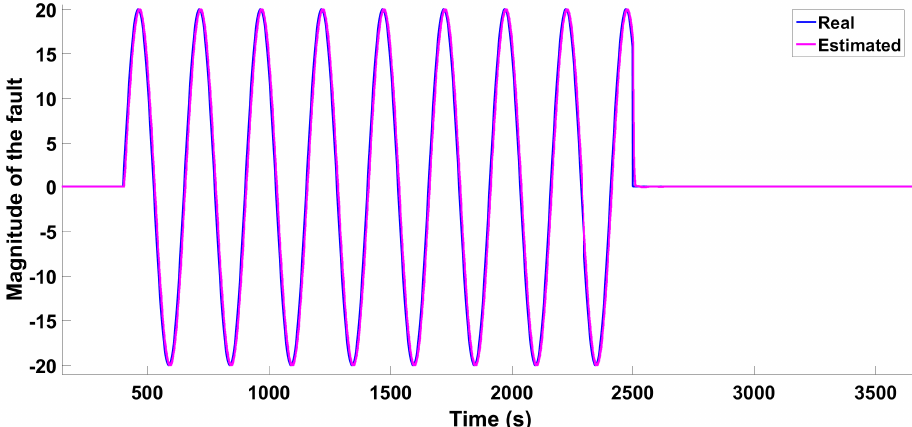
Figure 14. Scenario 1—Sine wave-type fault: Real and estimated sine wave-type fault on the reduced model (Hammerstein–Wiener).